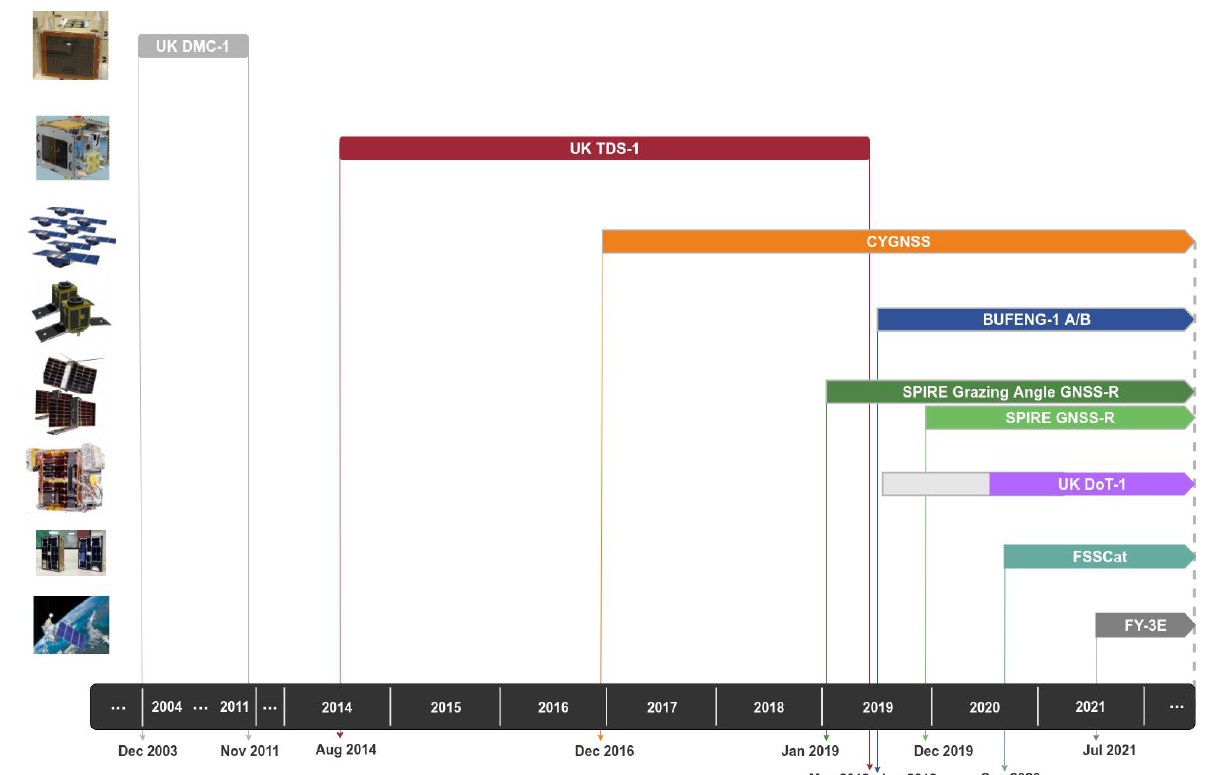
Figure 1. The evolution of spaceborne GNSS-R missions. Note: Spire grazing angle GNSS-R mea- surements have been acquired by upgrading the GNSS receivers’ firmware since early 2019, which were launched nominally to collect GNSS radio occultation measurements. DoT-1 satellite started to collect GNSS-R measurement by upgrading its payload firmware on September 2020, i.e., more one year after its launch. UK DMC, UK TDS-1 and UK DOT-1 image credits: SSTL. CYGNSS image